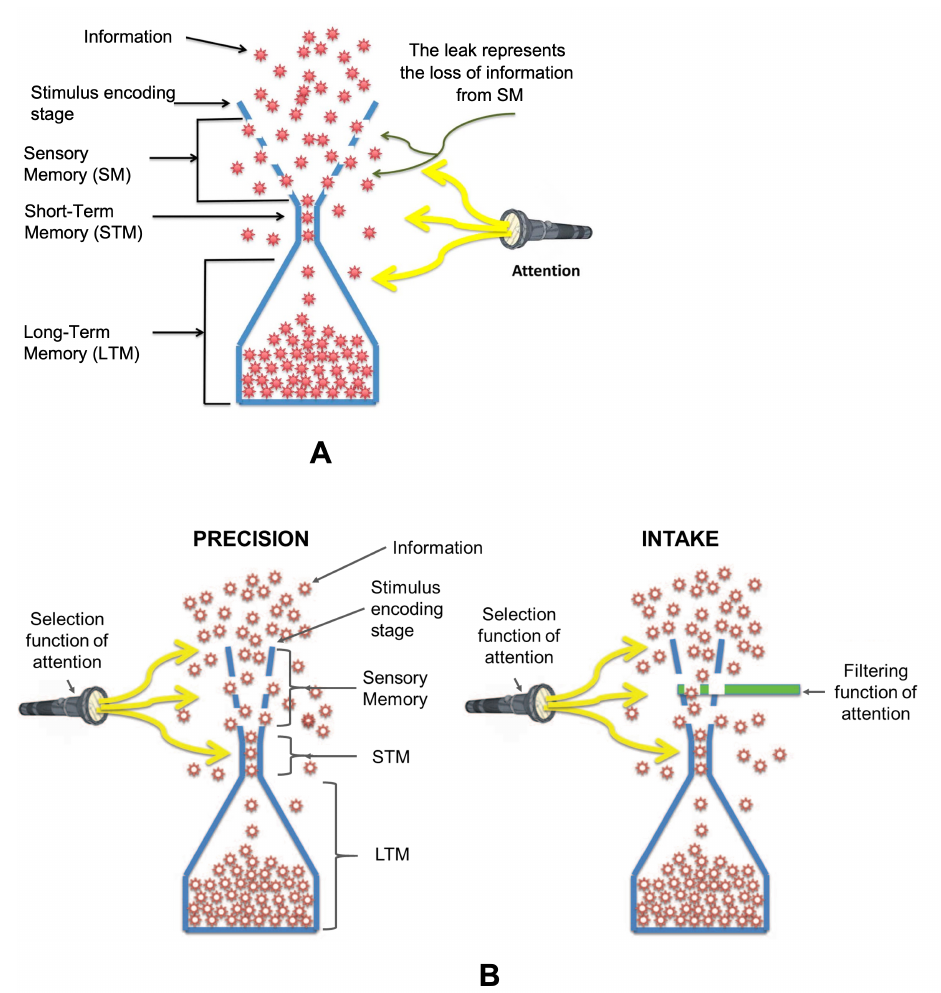
Figure 1. The leaky hourglass model ( A ) and the leaky flask model ( B ). In the leaky hourglass model, the large SM capacity is shown by the width of the hourglass at the top. The leak through the holes represents the fast decay of SM. The bottleneck is at the STM stage, which is followed by a large capacity LTM. In the leaky flask model, the top part is narrower, indicating information processing limits prior to STM. There are two leaky flasks, one representing the quality of information (precision) and the other the quantity of information (intake). The main bottleneck for the quality of information is at the stimulus encoding stage rather than the memory stage. The bottleneck for the quantity of information is more distributed, spreading from the encoding stage to the memory stage. Figure from Ö˘gmen et al.